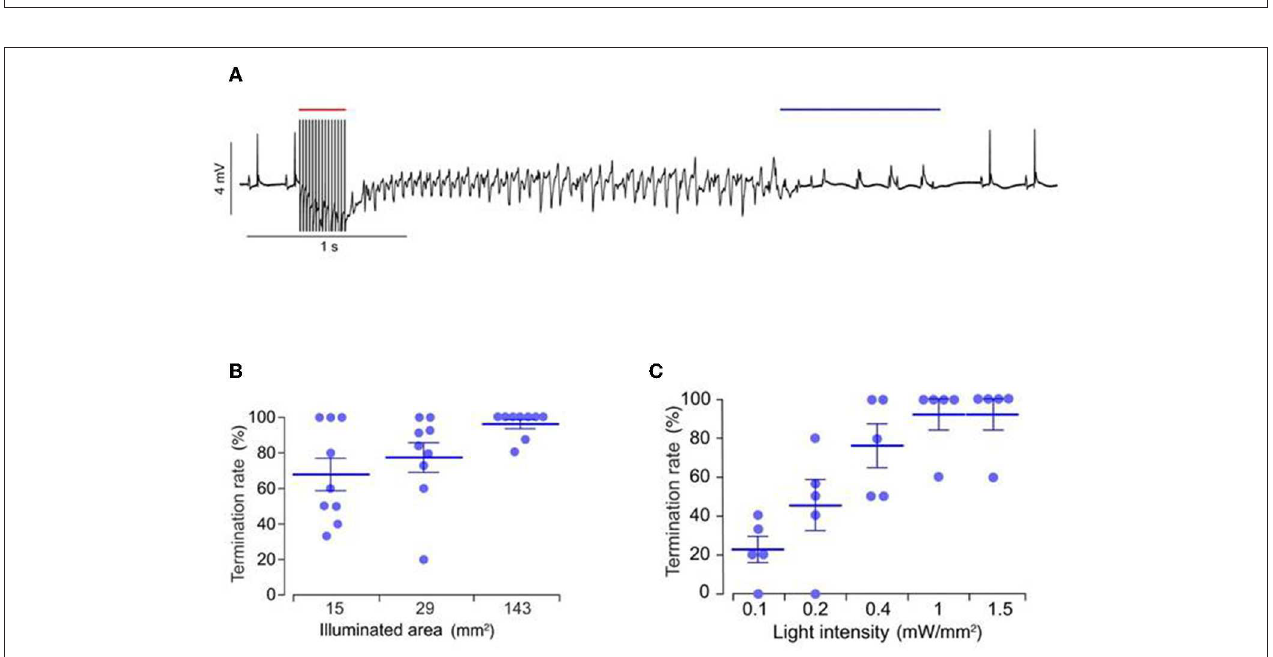
FIGURE 6 | with blue light, using LED-coupled fiber optic. For both configurations, ECG recordings show that heart beating rates increase with the flashing frequency of the light stimulus in a 1:1 ratio. Blue dots in the figure designate blue-light illumination (Scale 1cm). Cardiac resynchronization therapy using multi-site optogenetic pacing for isolated rat hearts, expressing ChR2 (B) . Two red circles mark ChR2 delivery sites for dual site-optogenetic pacing while white lettered “E” designates the placement of electrode during electrode pacing (a), optical maps and ECG recordings during: normal sinus rhythm (b), electrical pacing at the apex (c), single-site optogenetic pacing (d,e), and dual-site optogenetic pacing (f). Three red circles refer ChR2 delivery sites (g), optical maps and ECG recordings during: single-site electrical pacing (h), and multi-site optogenetic pacing (i). Multi-site optogenetic pacing lowered both the left ventricle activation time (14.8ms, see Optical map) and also the QRS durations (65ms, see ECG recordings) compared to those values from single-site right ventricular electrical pacing (i.e., 24.5 and 80ms, respectively). Reproduced with permission from Nussinovitch and Gepstein (2015).